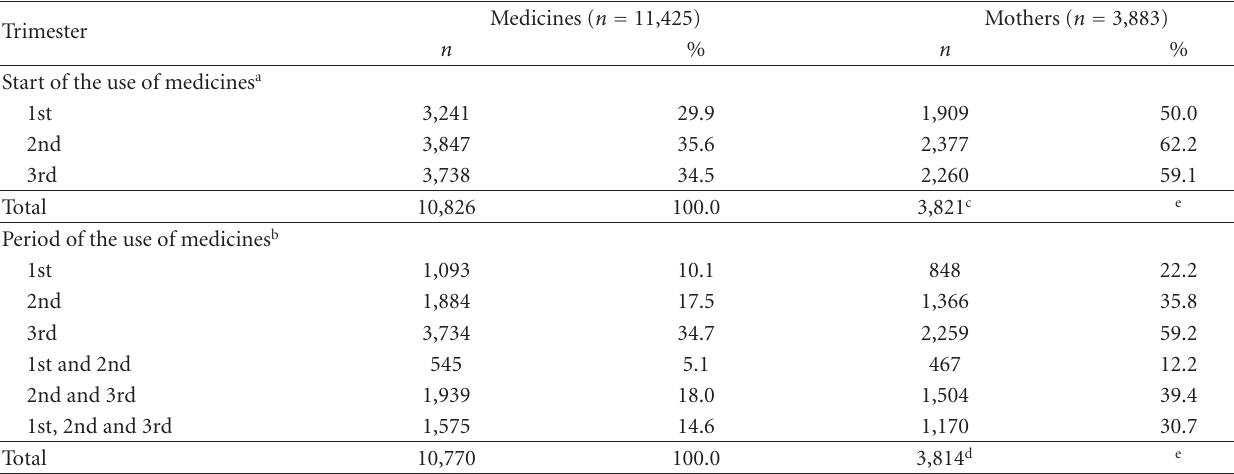
Table 1: Medicines used by the mothers participating in the 2004 Birth Cohort by the gestational trimester and percentages of mothers who used at least one medicine in the respective periods. Birth Cohort of Pelotas, RS 2004.